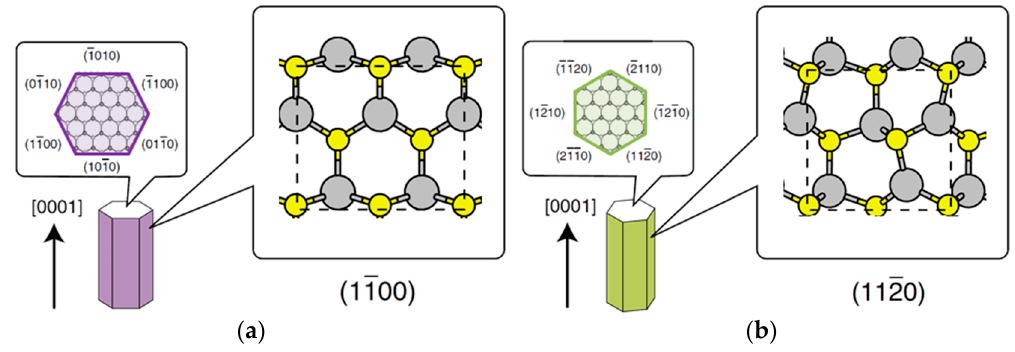
Figure 15. Schematics of InP NWs consisting of ( a ) { 1100 } and ( b ) { 1120 } side facets. Cross-sectional views and side views of NW facets are also shown. Dashed red lines in the top views represent unit cells. Large gray and small yellow circles represent In and P atoms, respectively.